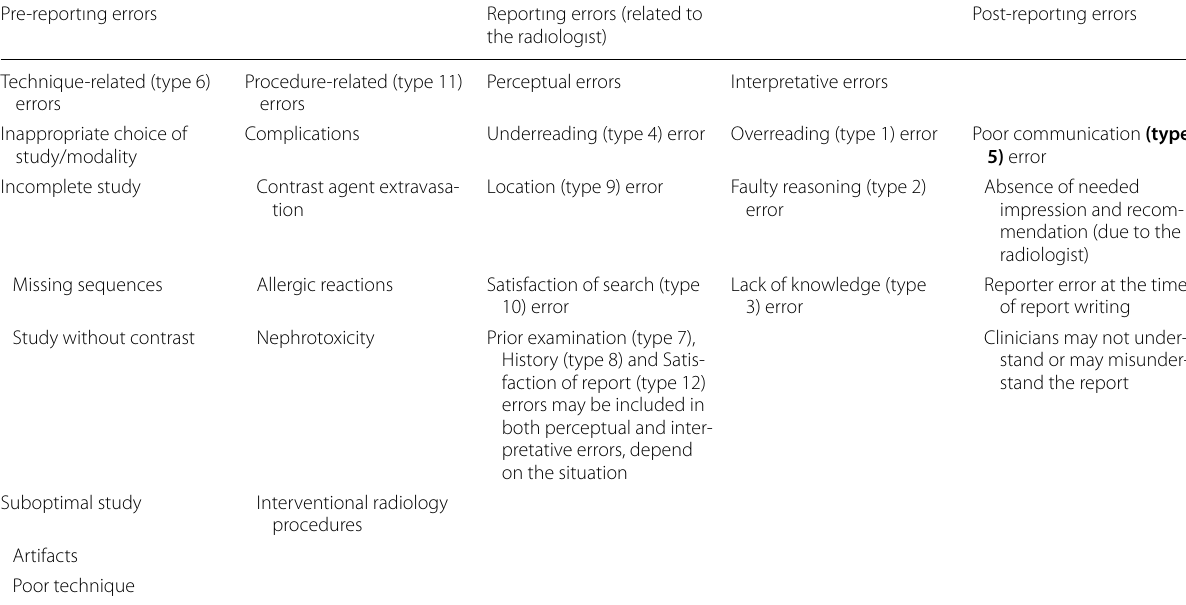
Table 1 Classification of radiological error types according to the reporting process